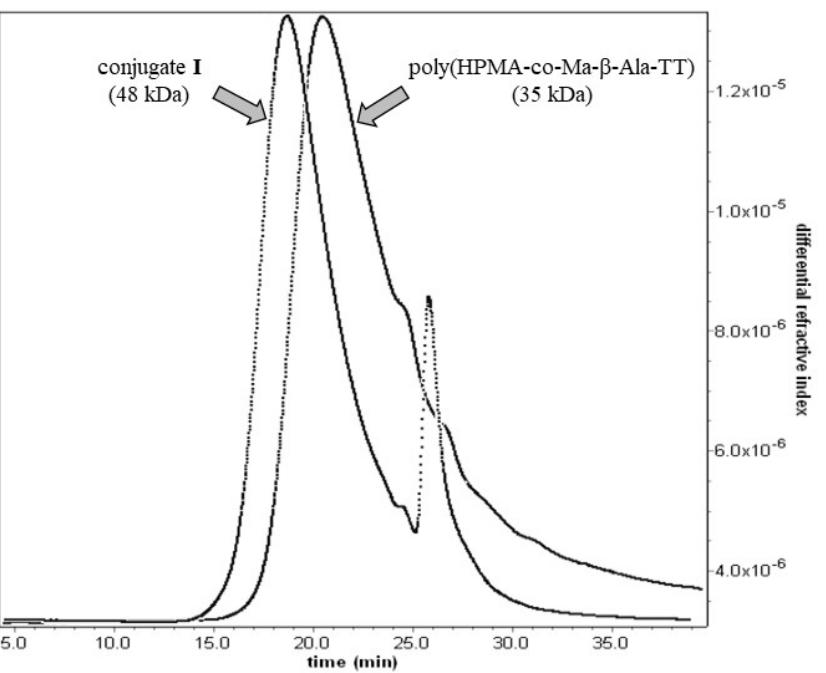
Polymers 2021 , 13 , 2530 Figure 6. Comparison of GPC curves of poly(HPMA- co -Ma- β -Ala-TT) and conjugate I . Table 1. Properties of polymer precursors and polymer conjugates.